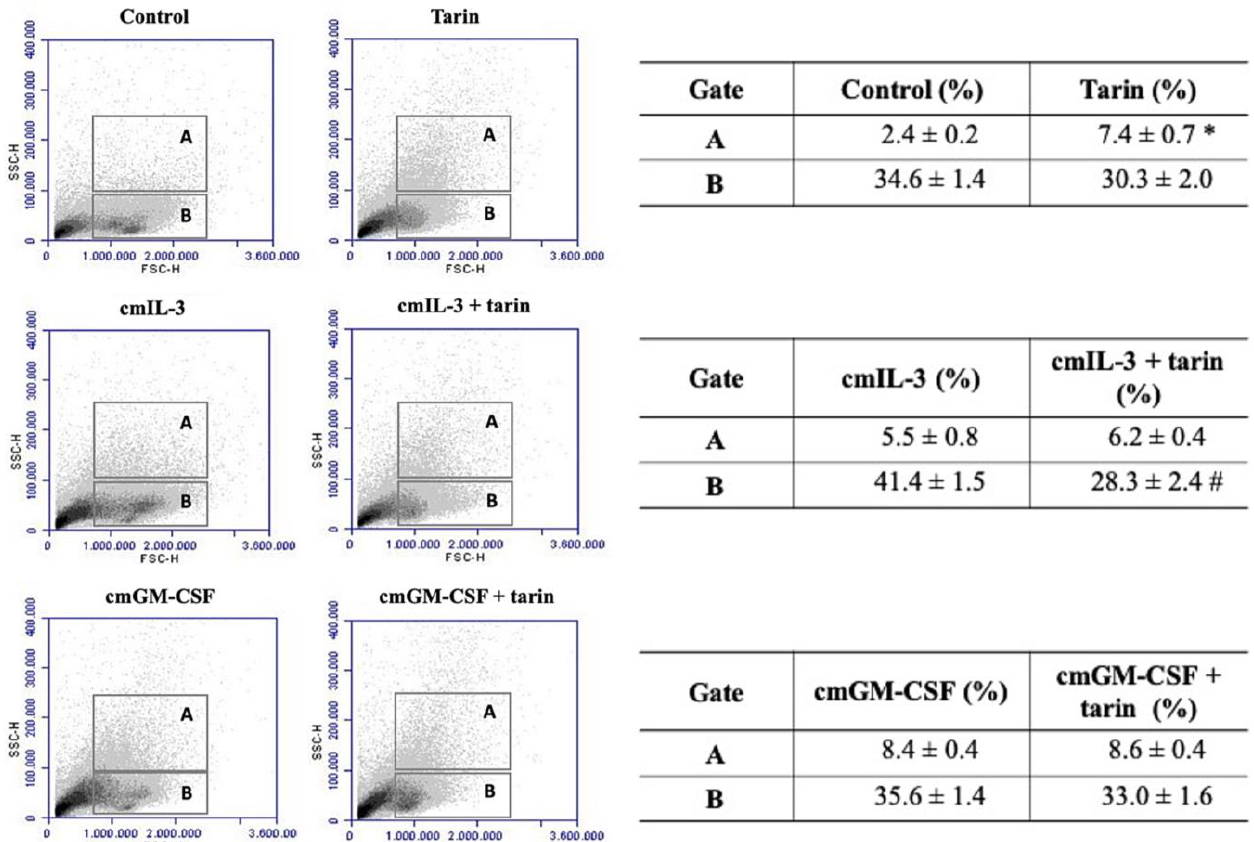
Figure 3. Effect of tarin and/or growth factors on the BM cell distribution profile during a 5 day-culture. Cells (2 × 10 6 cells/mL) from C57BL/6 mice bone marrows were cultured in an RPMI-1640 media (control) or challenged with 10% ( v/v ) of a conditioned medium highly enriched with IL-3 (cmIL-3) or GM-CSF (cmGM-CSF) or with tarin at 25 µg/mL. A flow cytometry analysis was performed, and cell percentages were analyzed in gates A and B, determined according to cell granularity (SSC—side scatter). The presented dot plots are representative of three independent experiments ( left panel ) and are expressed as means ± SD of bone marrow cell percentages ( right panel ). * and # indicate the significance level * p < 0.0001 compared to the control, and # p < 0.0001 compared to cmIL-3. IL-3—Interleukin 3; GM-CSF—granulocyte/macro- phage-colony-stimulating factor.